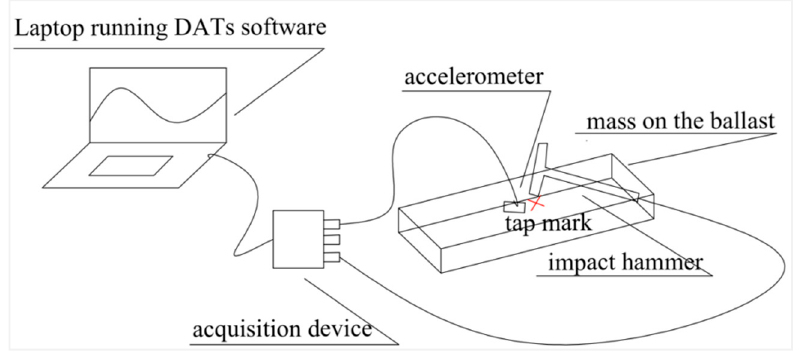
Figure 7. Capture data using the instrumented hammer.